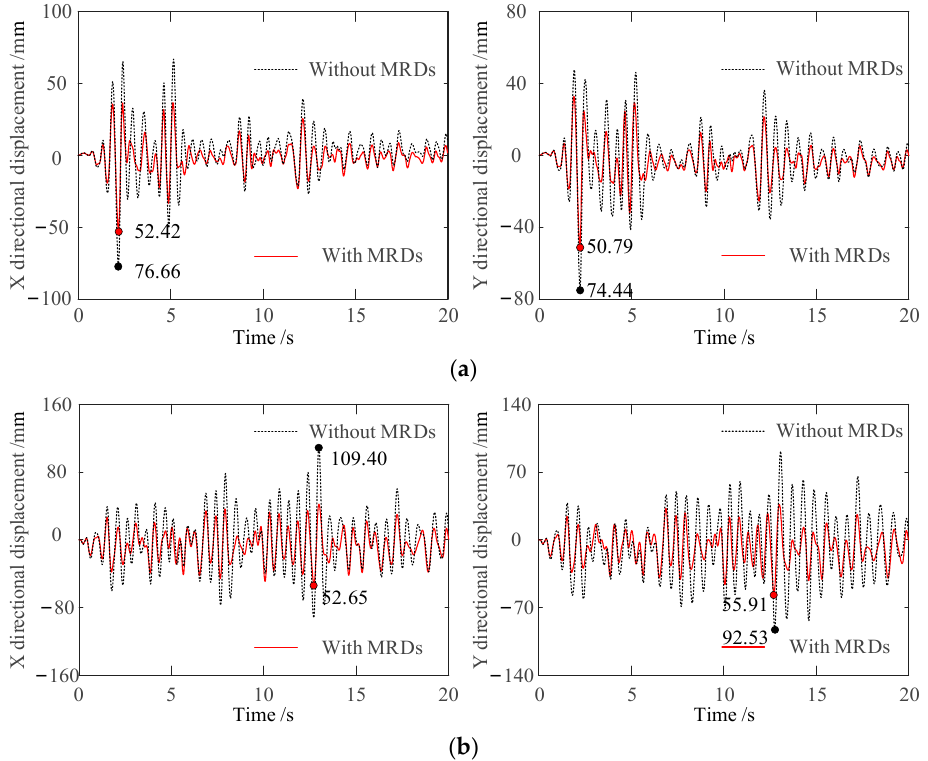
Figure 9. Comparison of horizontal bidirectional total displacement response of node 24 of RC frame structure. ( a ) Under the action of El-Centro wave; ( b ) under the action of Tangshan wave. Figure 9a,b shows that under the action of the El-Centro wave and Tangshan wave, the horizontal bidirectional displacement response of the node 24 in the structure with an MRD was reduced compared with the structure without an MRD. Figure 9a shows that, under the action of an El-Centro wave, the X and Y directional maximum displacements of the top node in the RC structure were 76.66 mm and 74.44 mm, respectively, after set- ting the MRD in the structure; the X and Y directional maximum displacements of the top node in the RC structure were 52.42 mm and 50.79 mm, which were reduced by 31.63% r d i Y